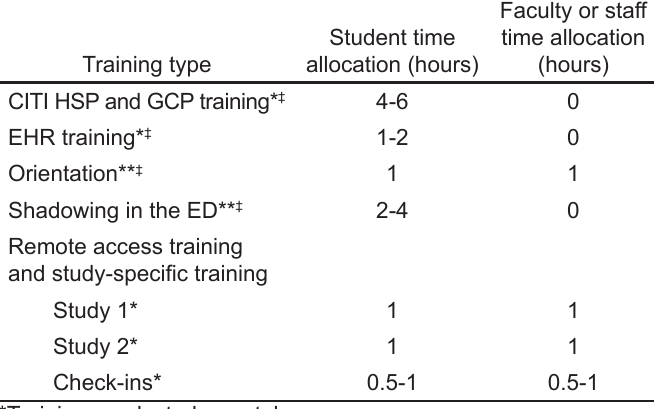
Table 1. Training types with time allocations for student research associates and